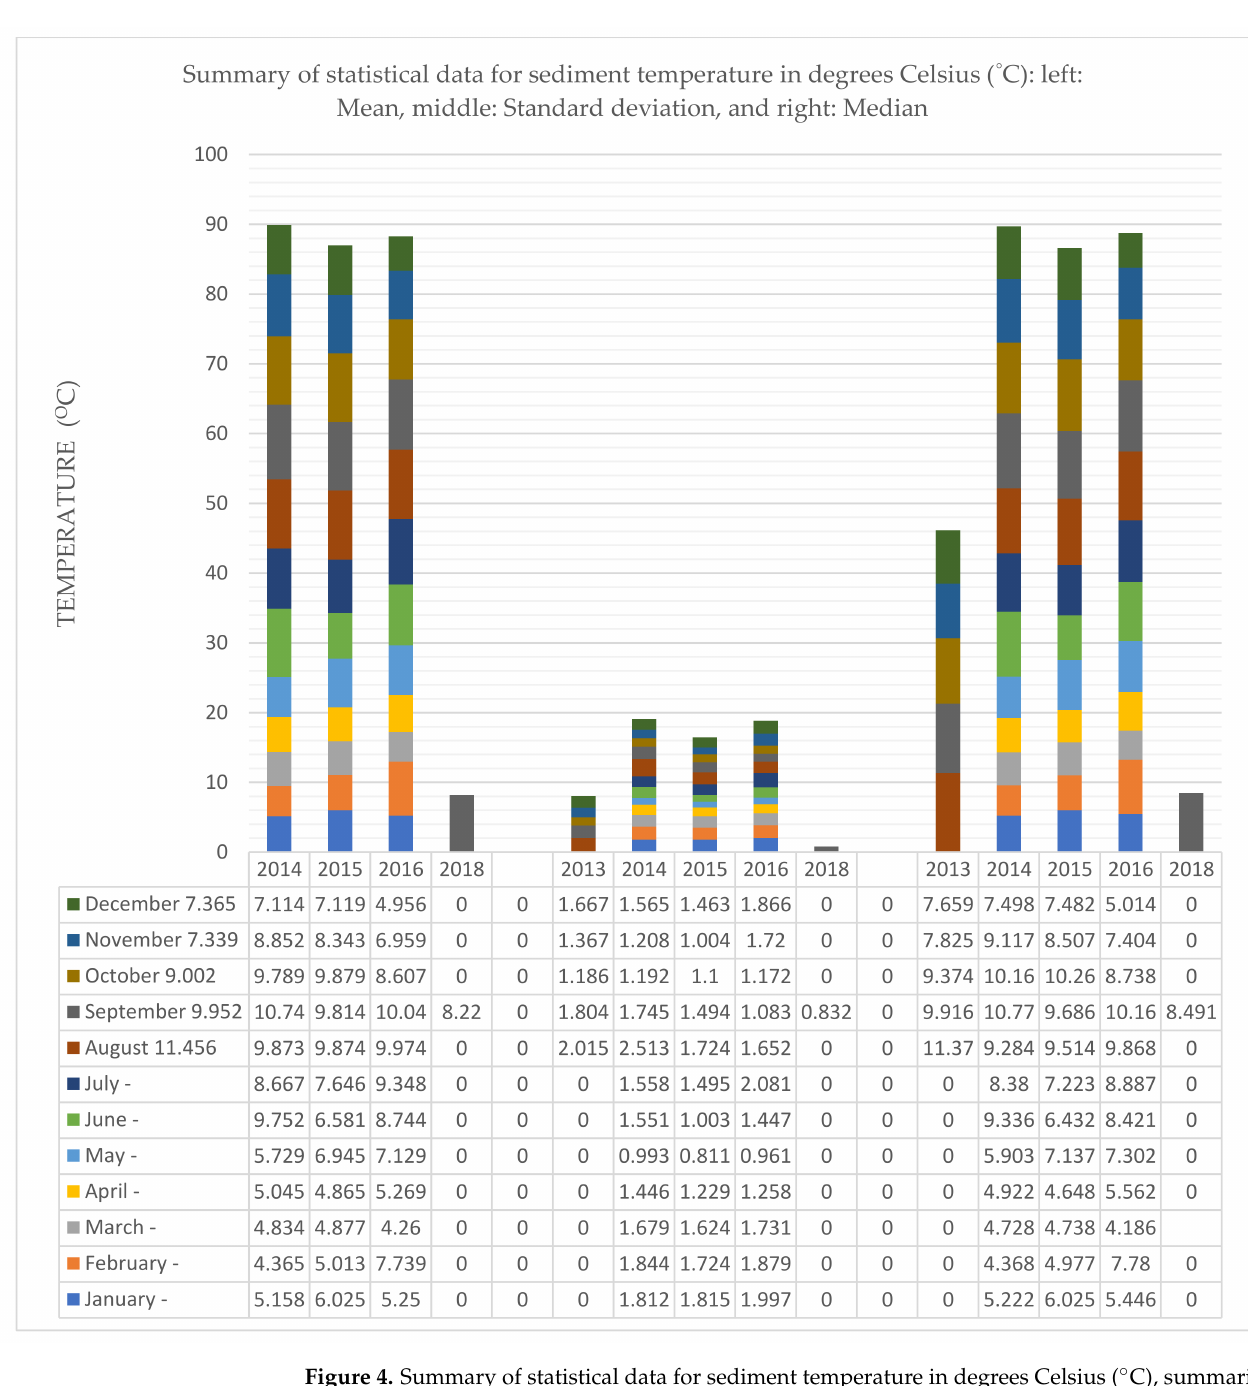
Figure 4. Summary of statistical data for sediment temperature in degrees Celsius ( ◦ C), summarized for whole depths: mean, standard deviation, and median at Suvilahti, Ketunkatu, in the city of